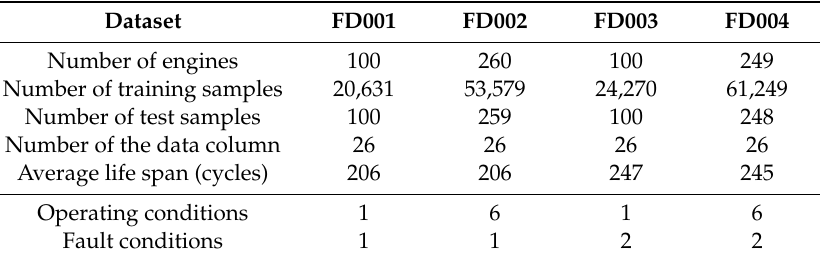
Figure 4. Diagram of the turbofan engine modules. Table 1. NASA C-MAPSS